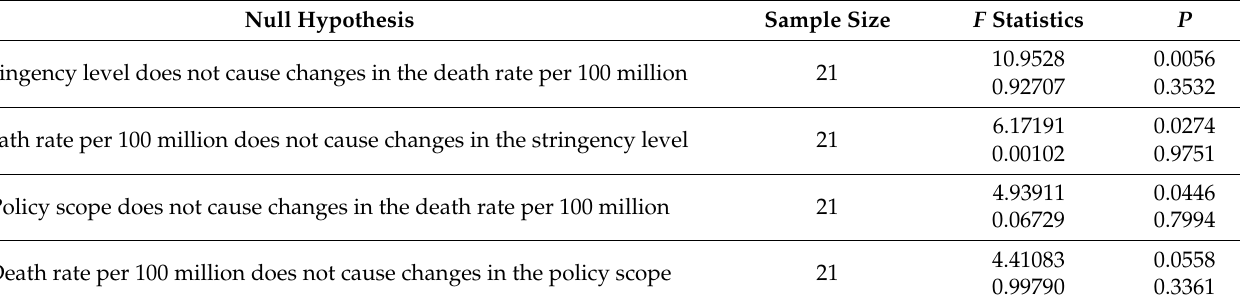
Table 9. Cointegration test